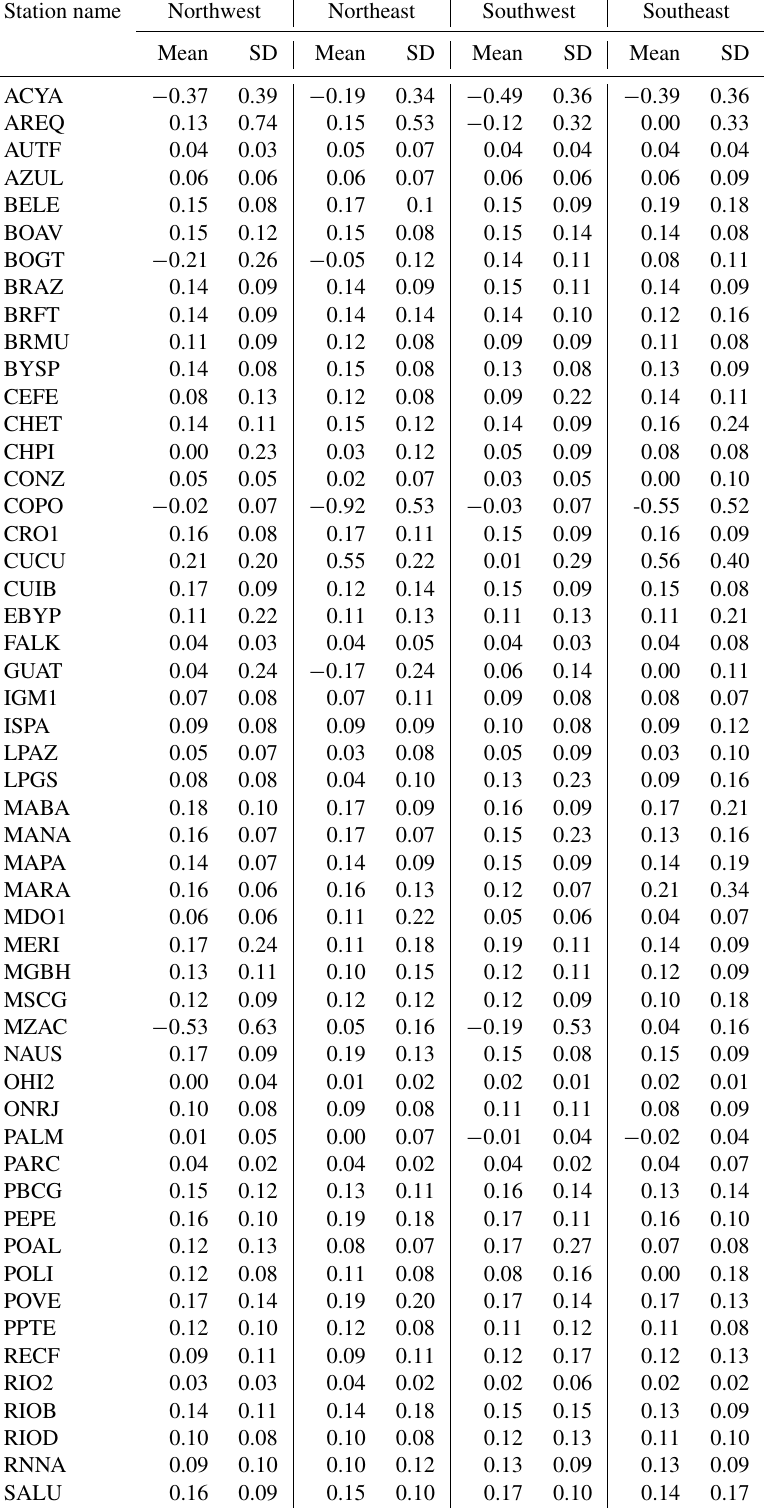
Table 3. Mean values of the difference between IWV ERA-Interim data and IWV computed from the numerical integral of Eq. (7) at each grid point surrounding the GNSS site. The integration limits range from 1hPa to the static geopotential value assigned by ERA-Interim to the point ( z k ERA-Interim